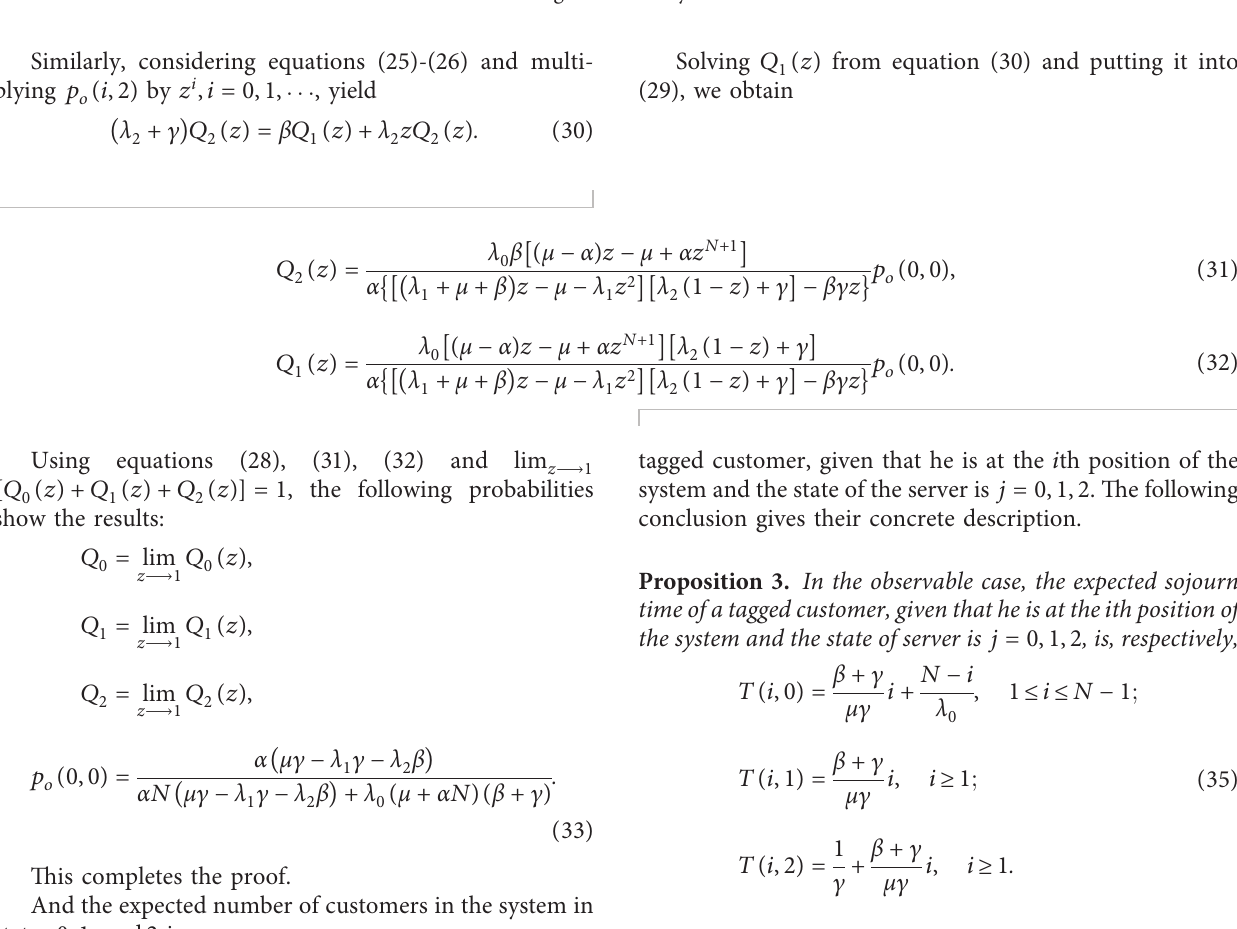
Figure 2: Transition rate diagram of the system in the observable